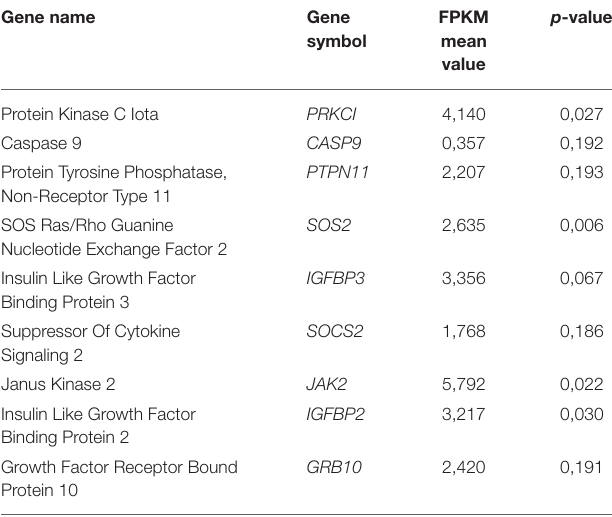
TABLE 5 | “IGF1 Signaling” pathway annotations—GCs from primordial follicles. TABLE 6 | “IGF1 Signaling” pathway annotations—granulosa cells from primary